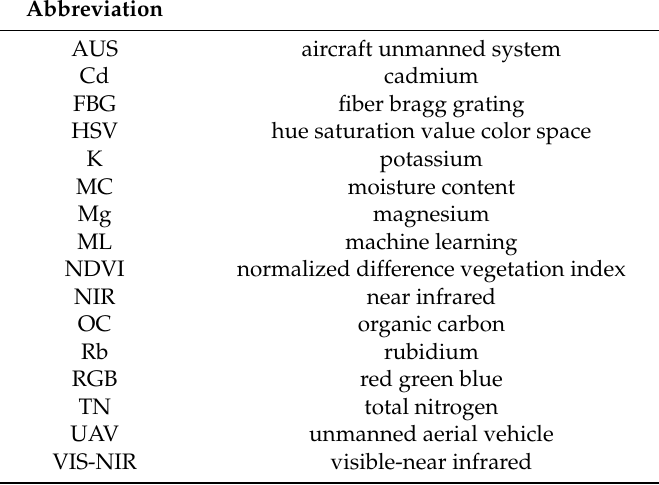
Table 4. General